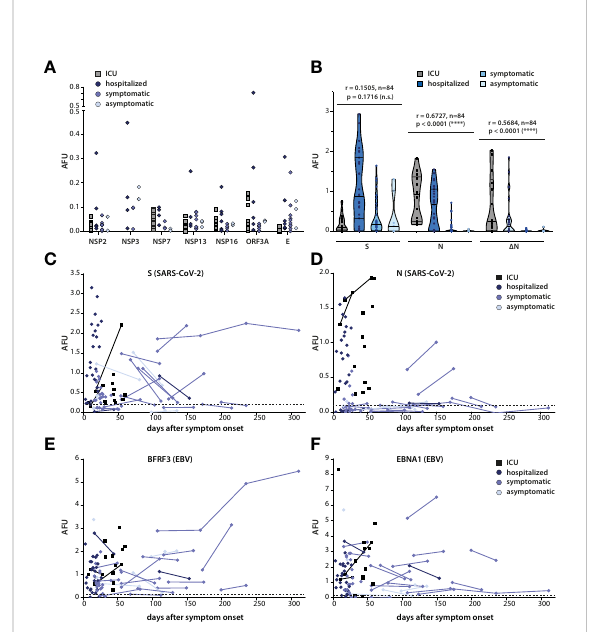
FIGURE 2 Correlation of kinetics and magnitude of the antibody response with disease severity. (A) IgG responses against selected SARS- CoV-2 antigens in the four clinical subgroups. (B) Correlation of IgG responses against S, N and D N with disease severity. Spearman correlation coef fi cient and p values are shown. (C – F) Antibody responses against S, N, BFRF3, and EBNA1 are displayed as arbitrary fl uorescence units (AFU) in SARS-CoV-2-infected persons subdivided into the indicated four clinical subgroups. Lines connect multiple measurement points in the same individual. In (A) and (B) , only values above cutoff are shown, in (C – F) , total values are plotted, and protein-speci fi c cutoffs are depicted as dashed